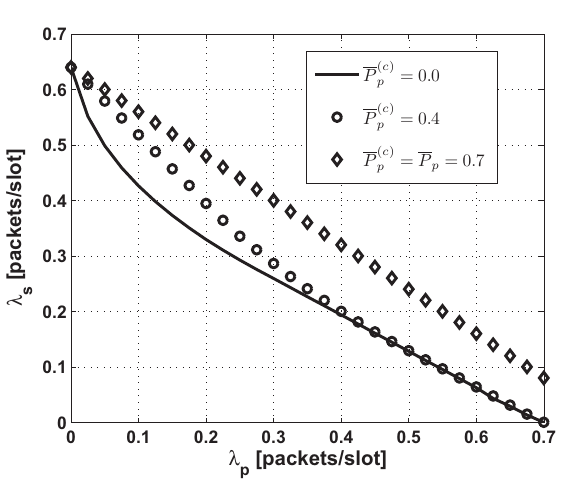
Figure 9. Maximum secondary throughput versus λ p for specific primary queueing